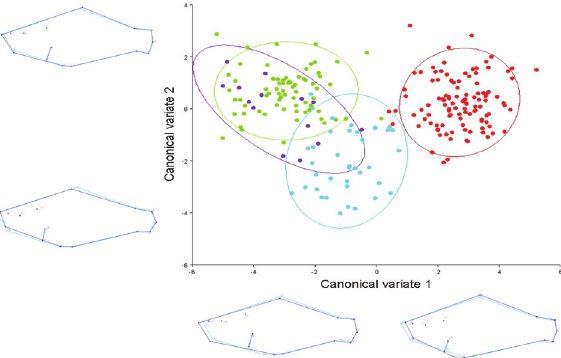
Figure 5. Canonical variate analysis of the morphometry of fe - males. Red dots = A. bellottii , Purple dots A. univentripinnis , Green dots = A. melanoorus , Skyblue dots = A. queguay . Defor - mation (dark blue line) from consensus configuration (sky blue line) associated to each canonical axis.